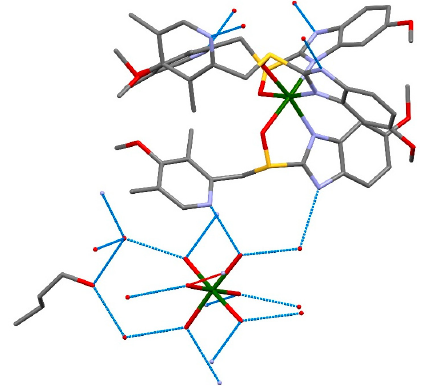
Figure 4. Two types of coordination around the magnesium centers, hydrogen atoms and non-bonded solvents have been omitted for clarity. Mg: green, S: yellow, O: red, N: blue, C: grey.